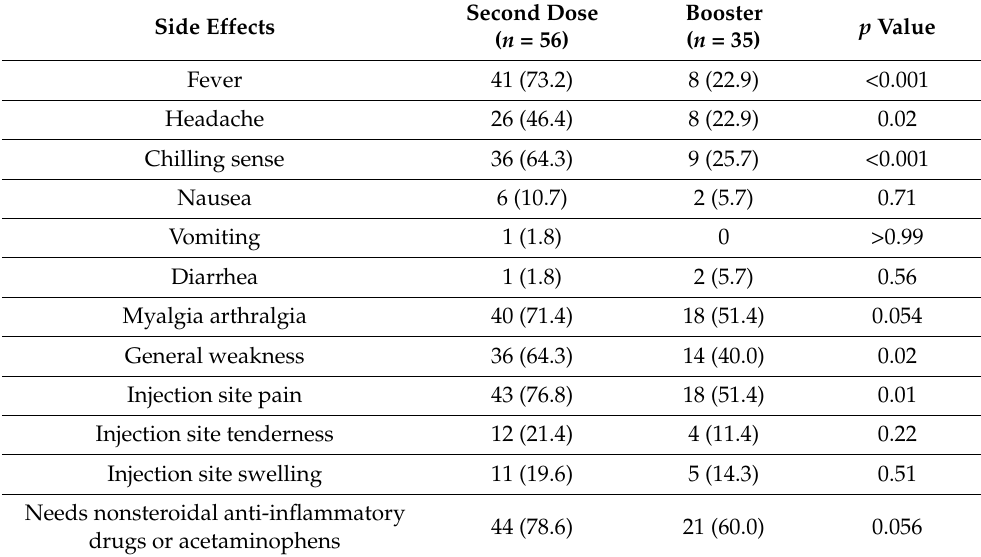
Table 1. Side effects after the second dose of vaccination and booster vaccination in medical stu- dents.